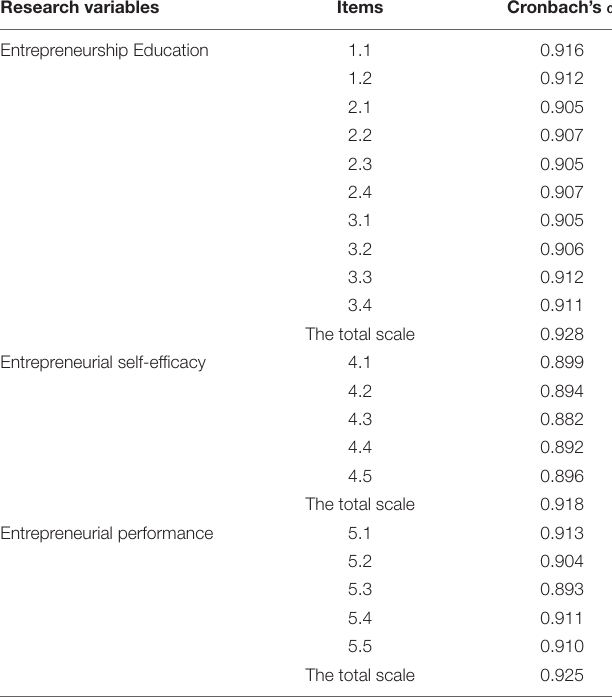
TABLE 4 | Results of reliability test.